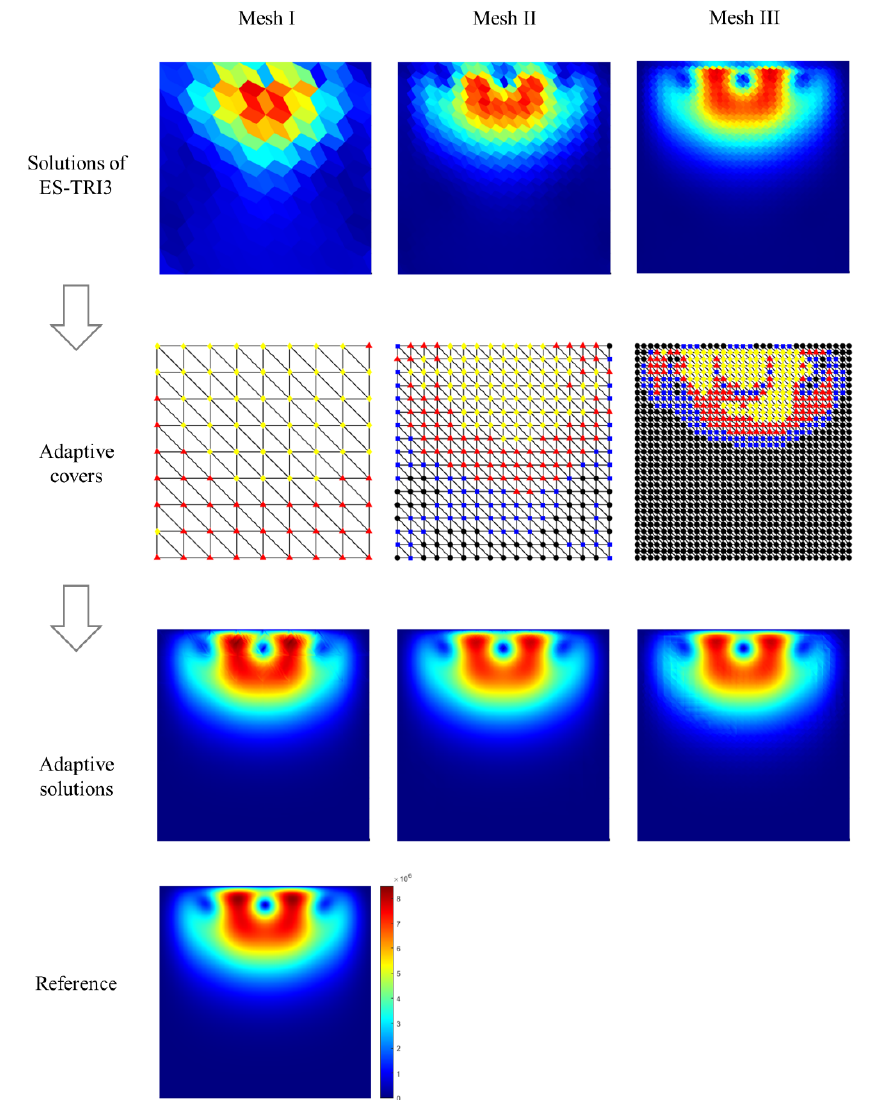
Figure 10. von Mises ( τ ) predictions obtained by the edge-based three-node triangular elements